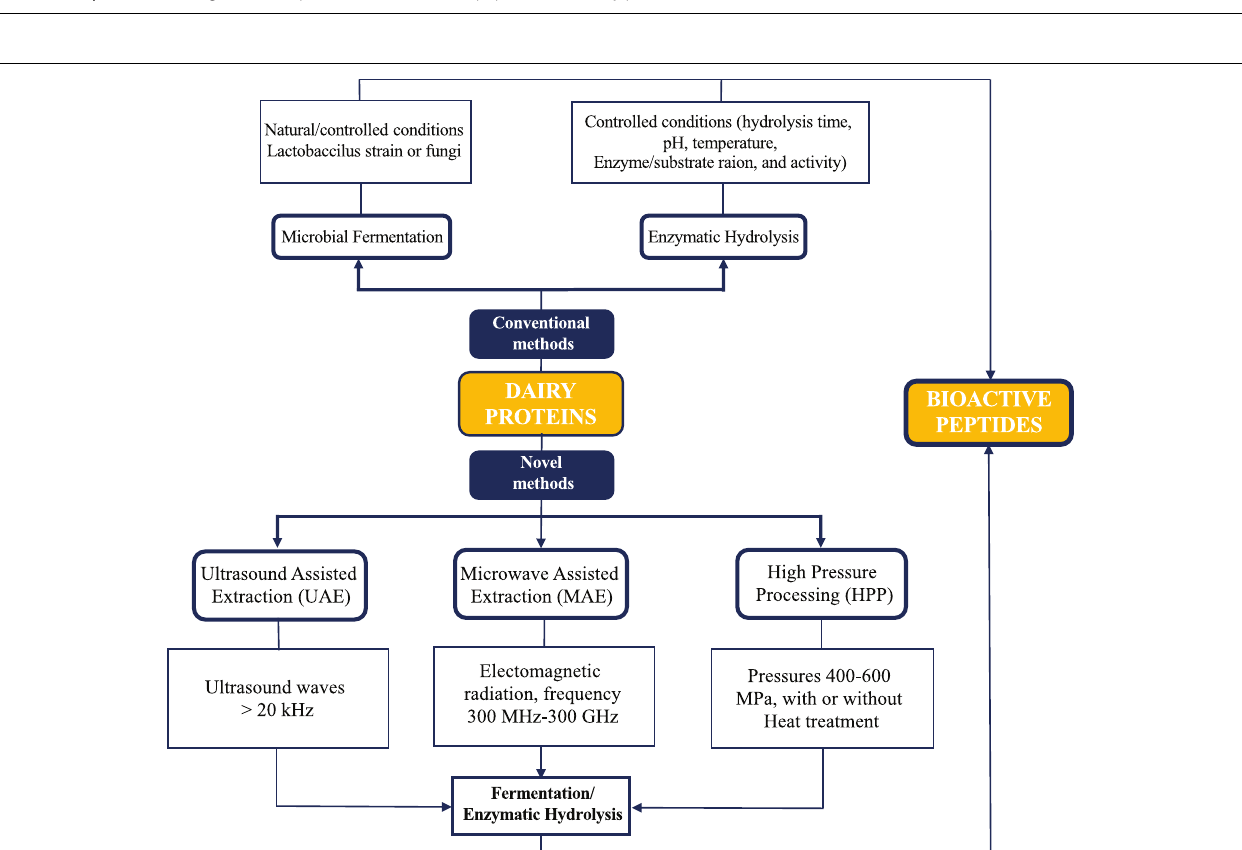
FIGURE 2 | Novel and conventional methods of bioactive peptides production from dairy proteins.